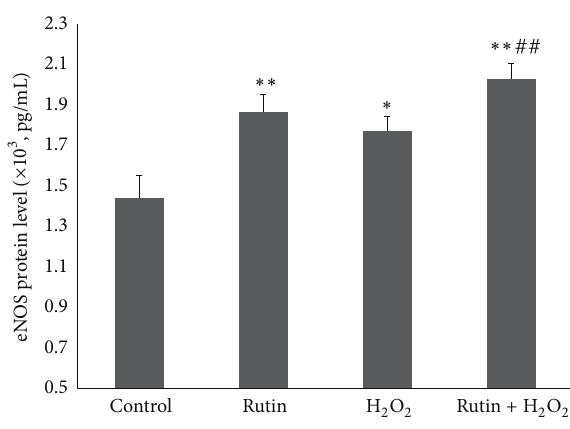
Figure 2: Bar chart showing eNOS protein level in control, rutin, H 2 O 2 , and rutin + H 2 O 2 groups. Values are expressed as means ± SEM of 𝑛 = 8 . ∗ 𝑃 < 0.05 versus control; ∗∗ 𝑃 < 0.01 versus control; and ## 𝑃 < 0.01 versus H 2 O 2 .